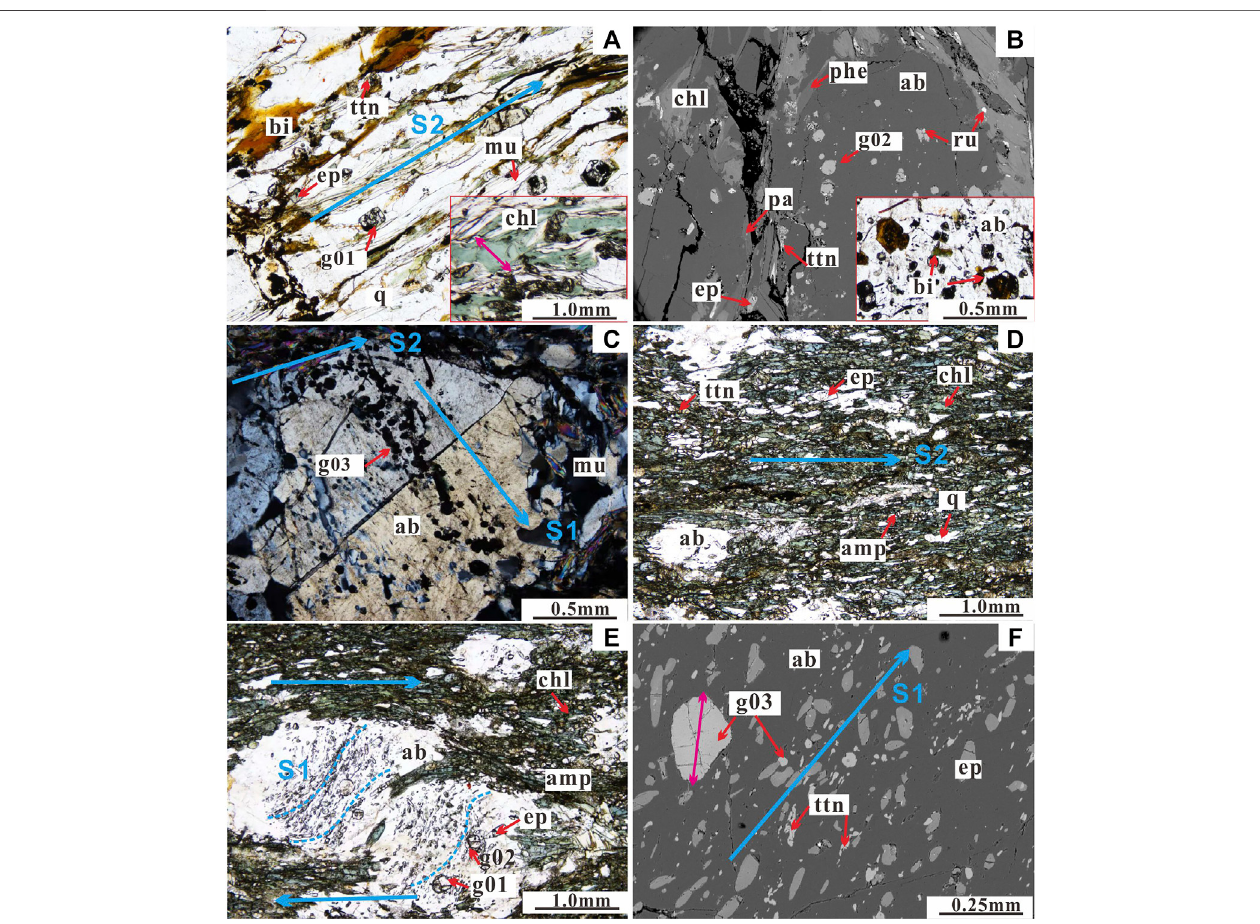
FIGURE4 | Microphotographsof newly discovered schistsfrom the Ondor Sum Group at Airgin Sum, central Inner Mongolia. (A) The foliated matrix composed of phengite, biotite, epidote, chlorite and titanite (S2 foliation) in sample EL01; (B) The BSE images showing albite porphyroblasts enclosing the early fi ne-grained garnet and the matrixminerals such asphengite, paragonite, biotite, quartzand rutileasinclusions; (C) The oriented garnetinclutionsinalbite porphyroblasts showingthe early foliation (S1) in sample EL04; (D) The foliated matrix composed of amphibole, albite, chlorite, epidote and titanite (S2 foliation) in sample EL08; (E) The syntectonic albite porphyroblast showing dextral movement along foliation S2 with oriented inclusions (S1) in sample EL08; (F) The BSE images showing inclusions of albite porphyroblastsuchasgarnet,epidote,amphiboleandtitaniteinsampleEL08.Themeasuredgarnetgrainsareshownwithdoublesidedarrow.Mineralabbreviations:bi, biotite; mu, muscovite; ep, epidote; chl, chlorite; amph, amphibole; g, garnet; phe, phengite; ab, albite; q, quartz; ttn, titanite; ru, rutile; pa, paragonite; q, quartz.